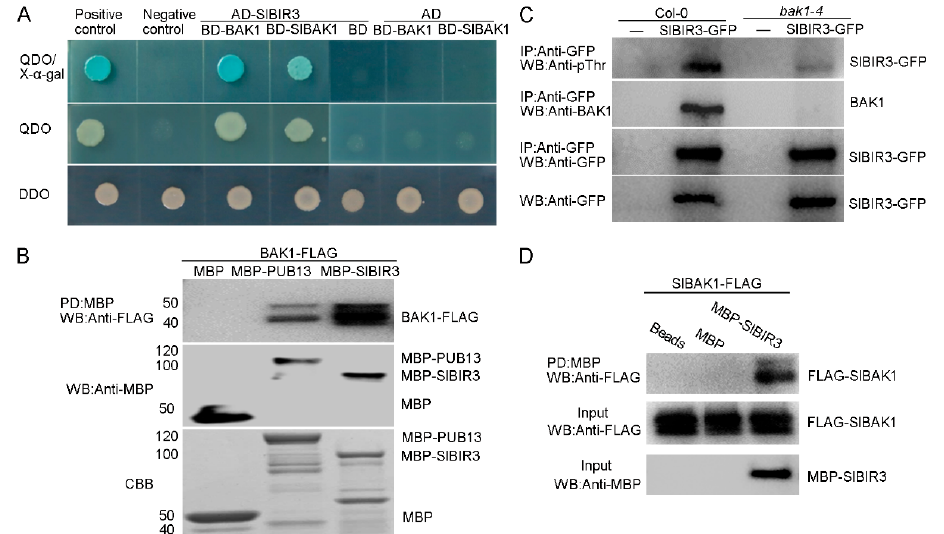
Figure 3. SlBIR3 interacts with BAK1 and SlBAK1. ( A ) SlBIR3 interacts with BAK1 and SlBAK1